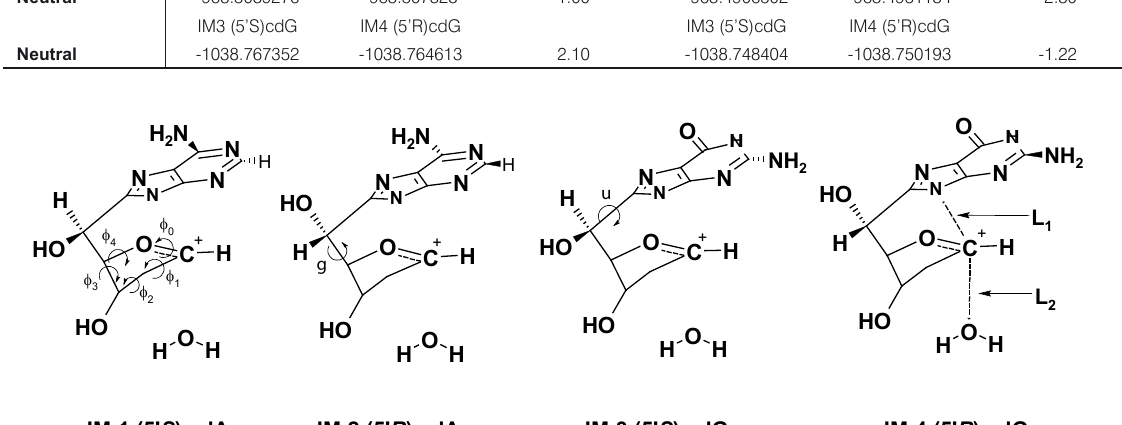
Figure 3. Graphical representation of four short-lived oxacarbenium ion intermediates with indication of the torsional angles in the sugar ring (symbols φ ; φ ;  φ ; φ ; φ ), υ -C 4’ -C 5’ -C 8 -N 7 indicates the new torsional angle that is unique for the hydrolysis product of the cyclic 0 1 2 3 4 nucleosides, γ - C 3’ -C 4’ -C 5’ -O 5’ and the distances between leaving group - carbenium ion (L